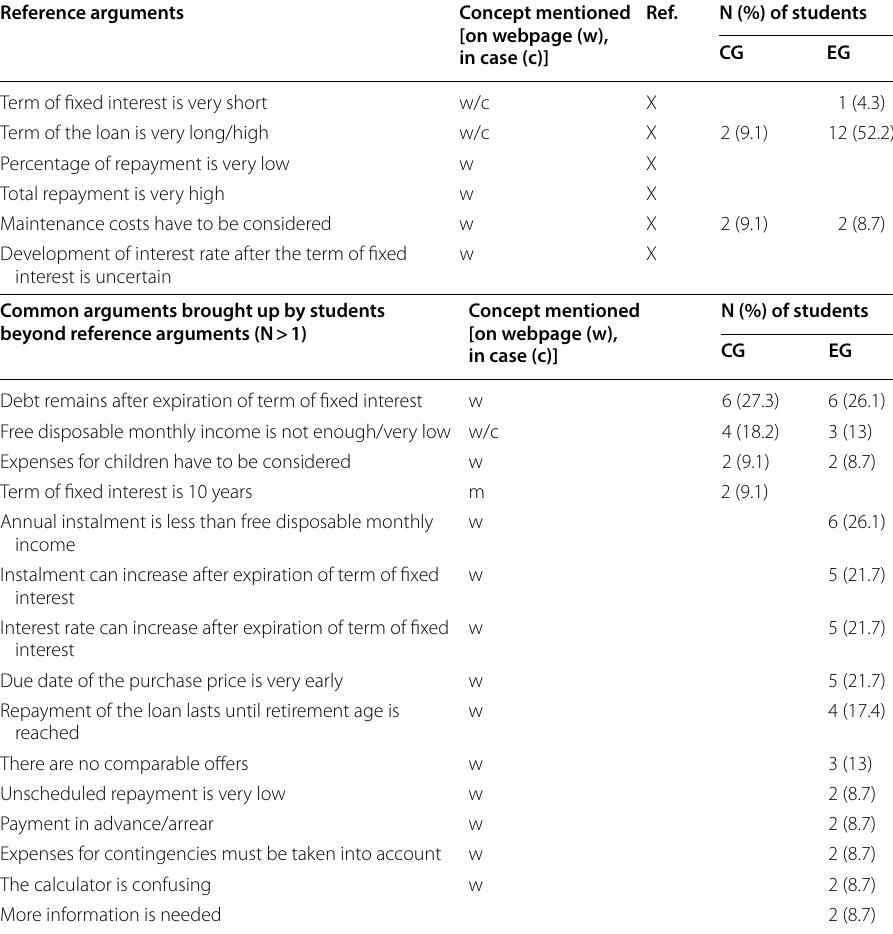
Table 7 Arguments against taking a mortgage loan (decision